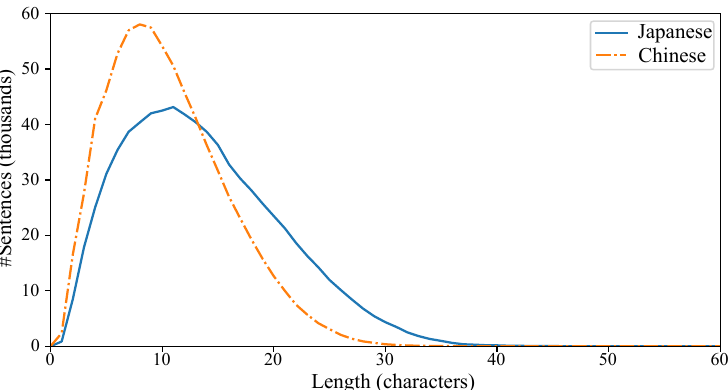
Figure 3. WCC-JC exhibits a right-skewed sentence length distribution: 5 Chinese and 14 Japanese sentences have length